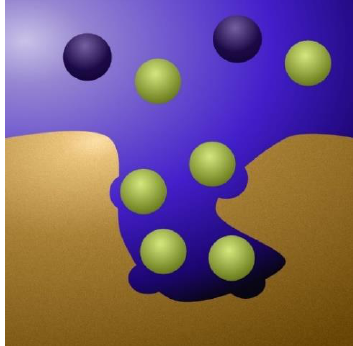
Figure 5. The same situation as in Figure 4 but from a Langmuir adsorption perspective. Depending on the material, applied voltage, etc., there are only a fixed number of sites onto which the ions can be adsorbed.